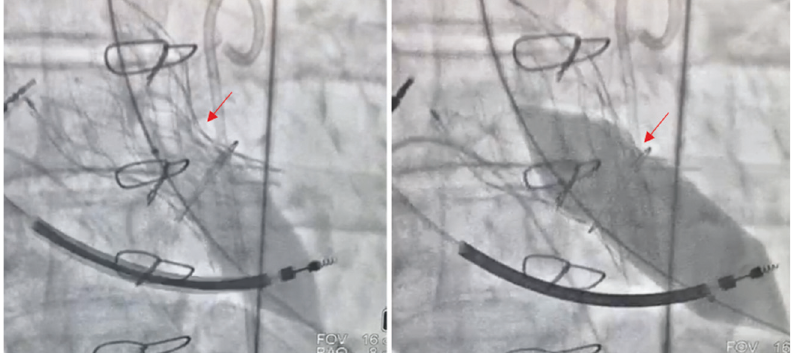
Figure 2: Example of a balloon valve frame fracture using a noncompliant balloon and high-pressure inflation. Observe the prosthesis waist before (first image) and after (second image) the balloon inflation.